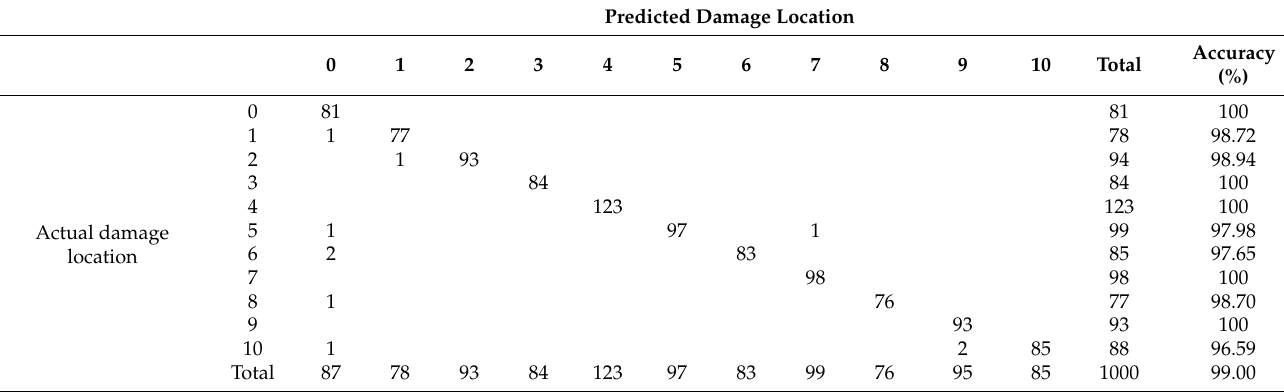
Table 9. Classification result of application datasets under traffic loading